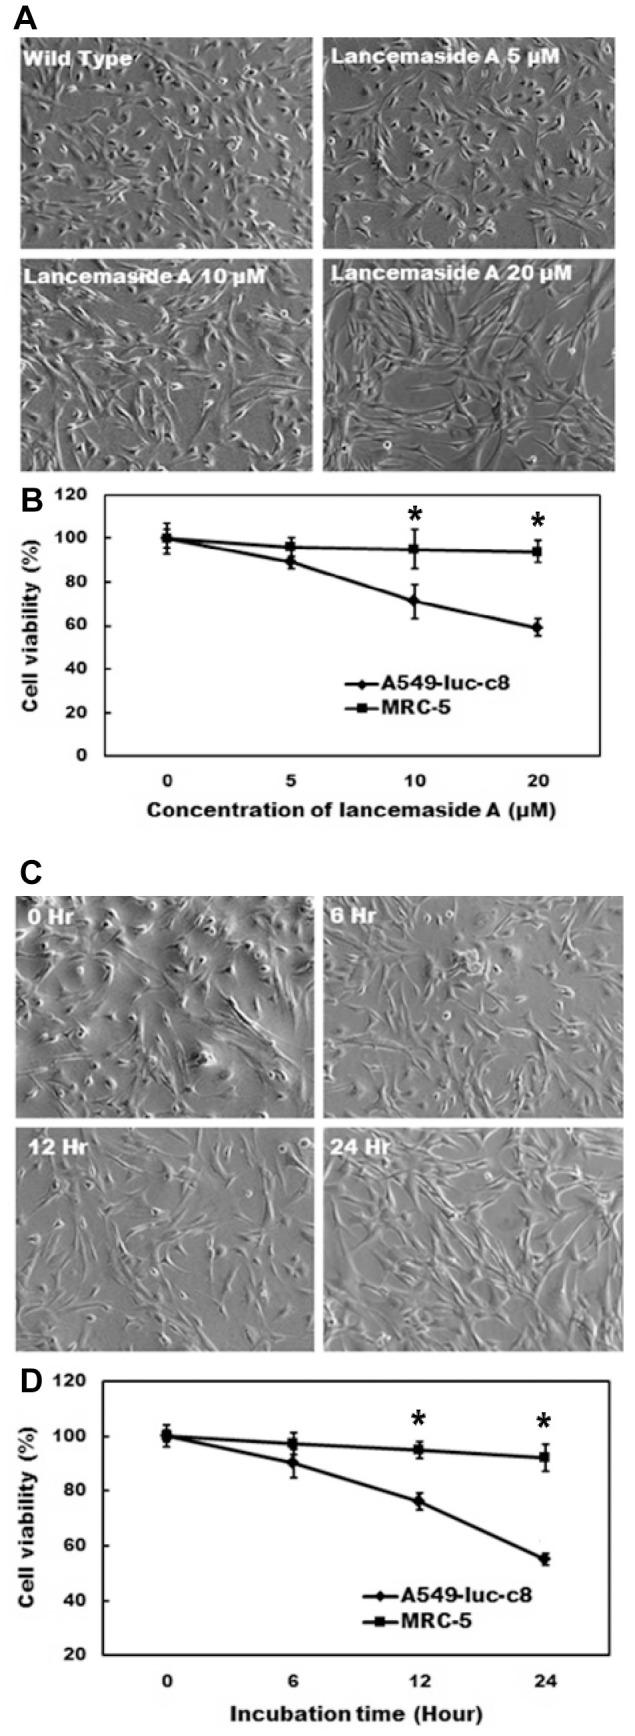
The cytotoxicity of LAN-A against co-cultured MRC-5 and A549-luc-c8 cell lines.(A) Representative images for the different treatment groups were captured 12 h post treatment. (B) Images from three independent experiments were manually counted for the live/dead cells for the different treatment groups. Data were plotted and shows the percentage of live cells. Student's T test was performed on the data sets to determine significant differences (* = p<0.05). (C–D) Co-cultured cells were exposed to 10 µM LAN-A and then monitored for cell death at different times post treatment. Cell death was determined as described above. Data are from three independent experiments.